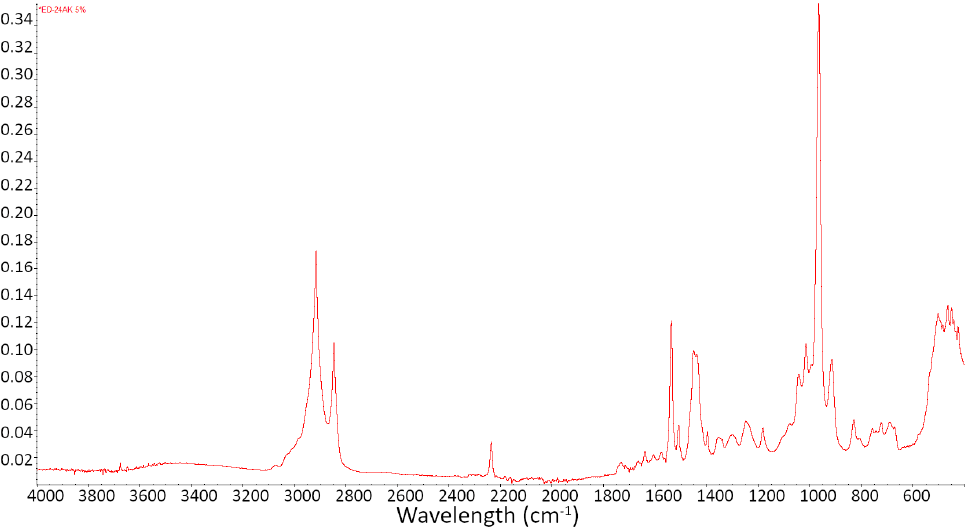
Figure 10. FT-IR spectrum of NBR modified with 5 wt.% ED-24AK after vulcanization. As in the case of samples with unmodified resin, along with an increase in the ED-24 AK content, we observe a slight decrease in the rubber peaks and an increase in the resin peaks (Figure 11). The peaks from adipic acid are slightly strengthened, although this is a smaller increase than in the case of the peaks from ED-20, which again confirms that the acid is there but its content in the resin is small.